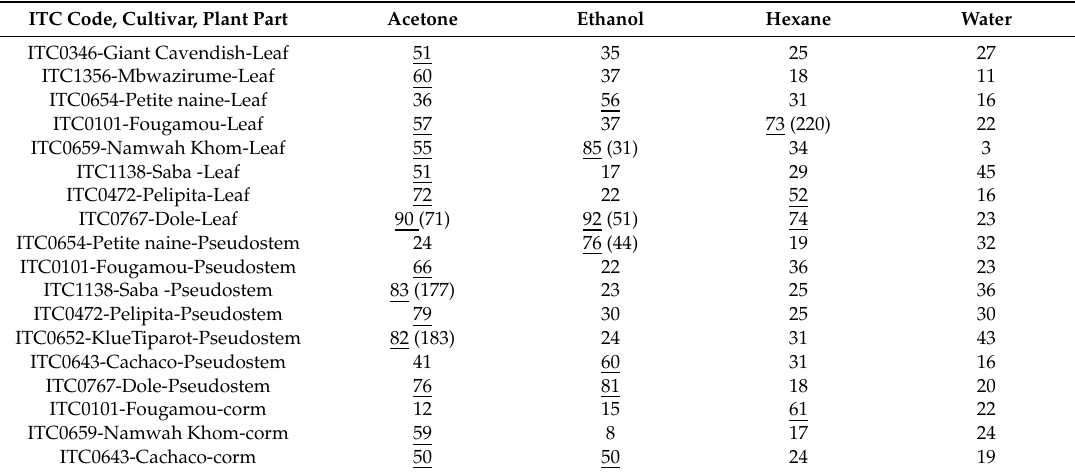
Table 6. Summary of Candida anti-biofilm activity (BIC 50 in µ g / mL).